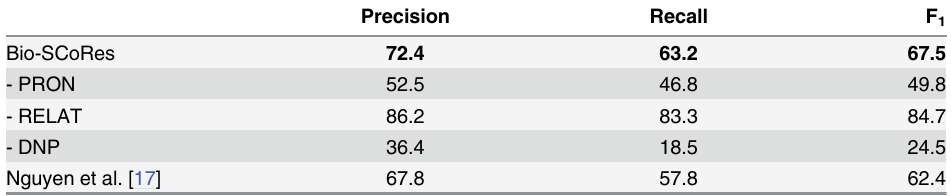
Table 15. Evaluation results on the development portion of the Protein Coreference